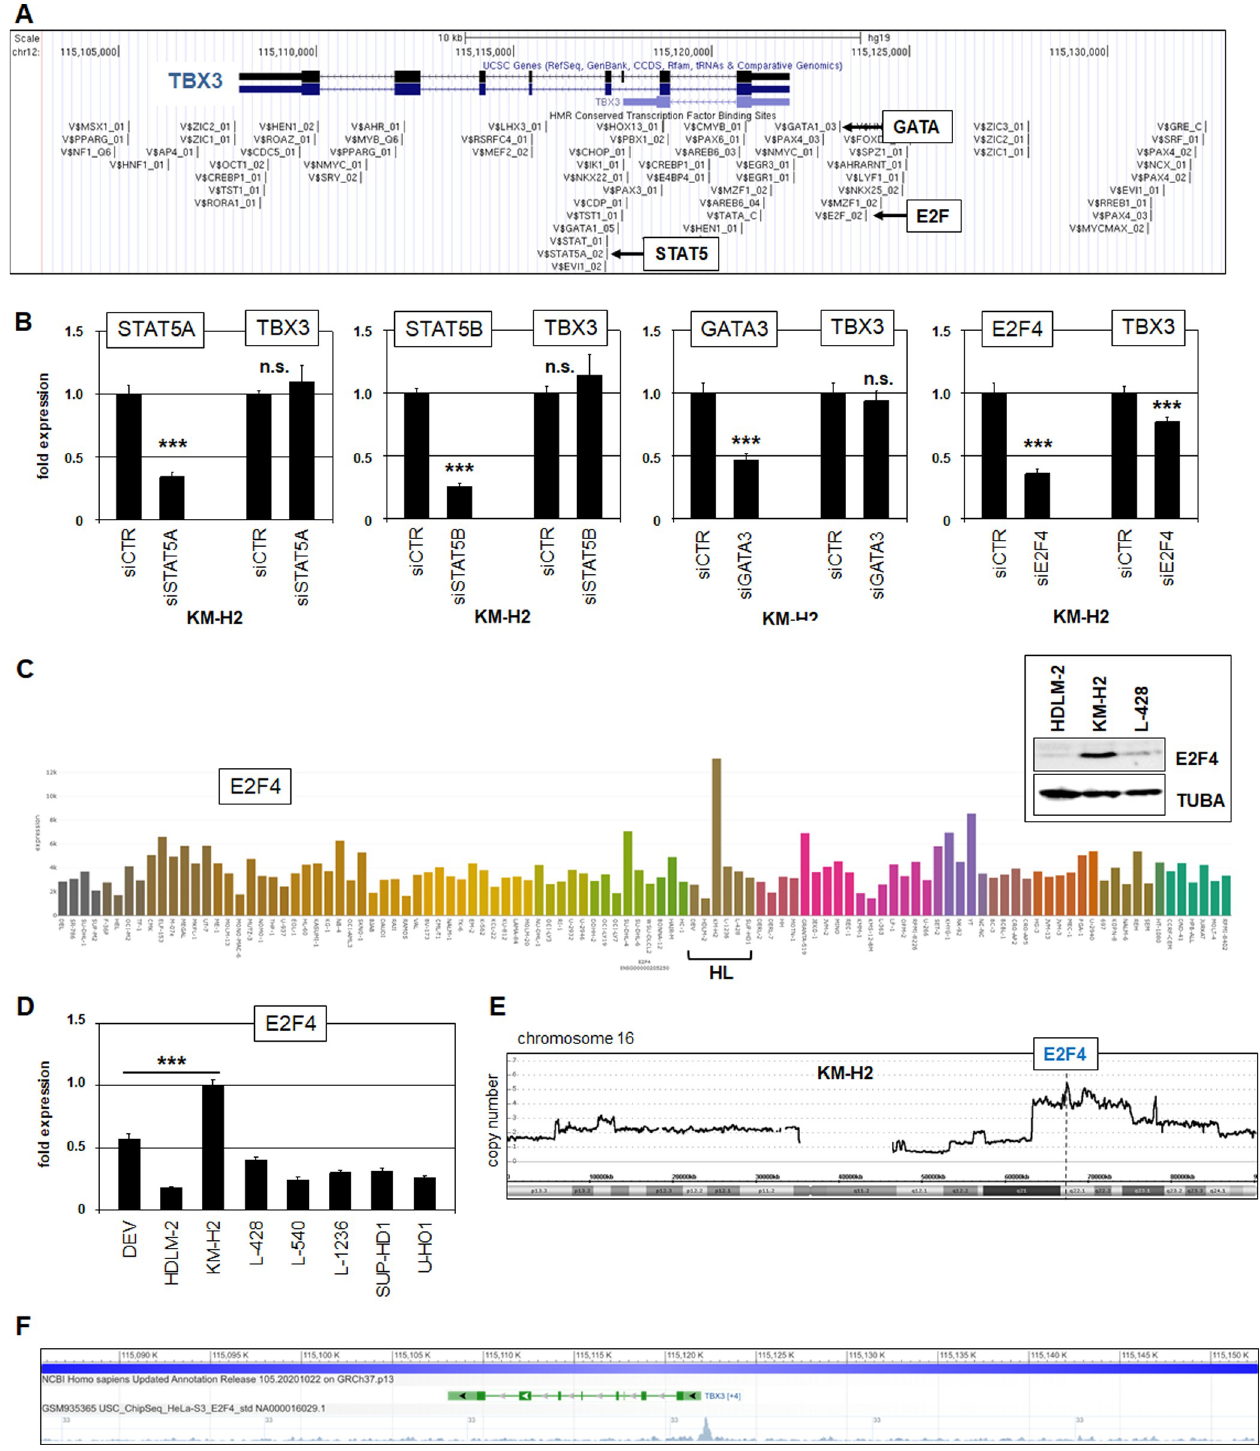
Fig 4. TBX3 promoter analysis. (A) Potential TF binding sites at the TBX3 locus obtained from the UCSC genome browser (hg19). Binding sites for the TFs STAT5, GATA and E2F are highlighted. (B) RQ-PCR analysis of TBX3 after siRNA-mediated knockdown of STAT5A, STAT5B, GATA3, and E2F4. The data indicated that E2F4 activated TBX3 while STAT5A, STAT5B and GATA3 showed no transcriptional impact. (C) RNA-seq data show expression levels of E2F4 in 100 leukemia/lymphoma cell lines using dataset E-MTAB-7721. Western blot analysis of E2F4 protein in HL cell lines HDLM-2, KM-H2 and L-428, demonstrating high levels in KM-H2. TUBA served as loading control (insert). (D) RQ-PCR analysis of E2F4 expression in HL cell lines, confirming elevated